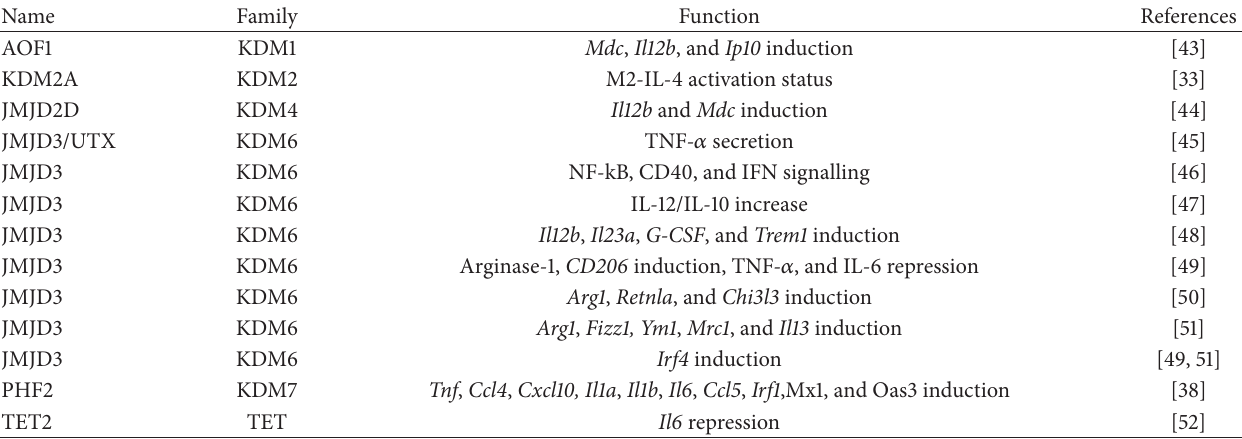
Table 2: DMTs involved in macrophage